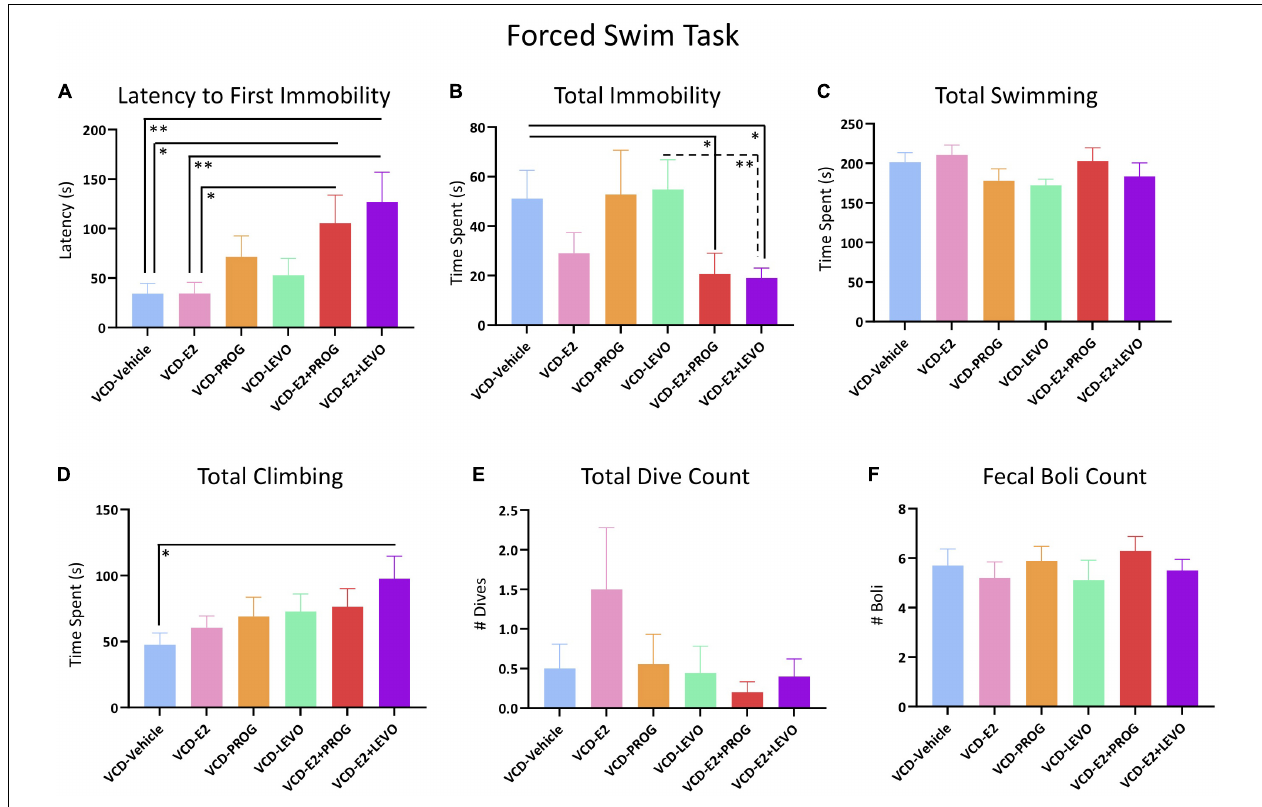
FIGURE 11 | Forced Swim Test. (A) Both combination hormone therapy groups had a longer latency to immobility when compared to VCD-Vehicle or VCD-E2 groups, suggesting an antidepressant-like effect of combination hormone therapy compared to no treatment or E2 treatment alone. (B) Total immobility was decreased in the combination hormone therapy groups, again suggesting an antidepressant-like effect compared to Vehicle treatment or LEVO-alone treatment. (C) No Treatment differences were indicated in time spent swimming. (D) The VCD-E2 + LEVO group spent more time climbing compared to the VCD-Vehicle group, indicating antidepressant-like effects. (E,F) Total Dive Count and Fecal Boli Counts did not differ among treatment comparisons. Significance: ∗ = p < 0.05, ∗∗ = p <